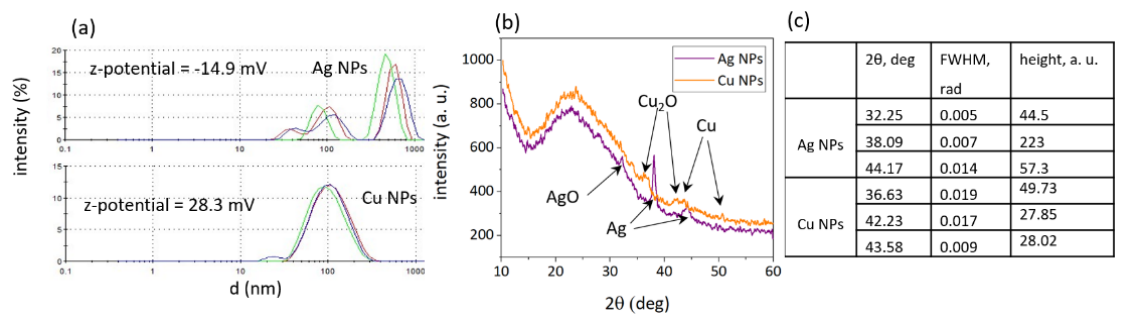
Figure 3. ( a ) DLS size distribution of Ag and Cu NPs with corresponding Z ‐ potential values (green, red and purple lines represent the results of three measurements of the same samples); ( b ) XRD spectra of Ag (purple line) and Cu (orange line) NPs; ( c ) data of XRD pattern of Ag and Cu NPs.